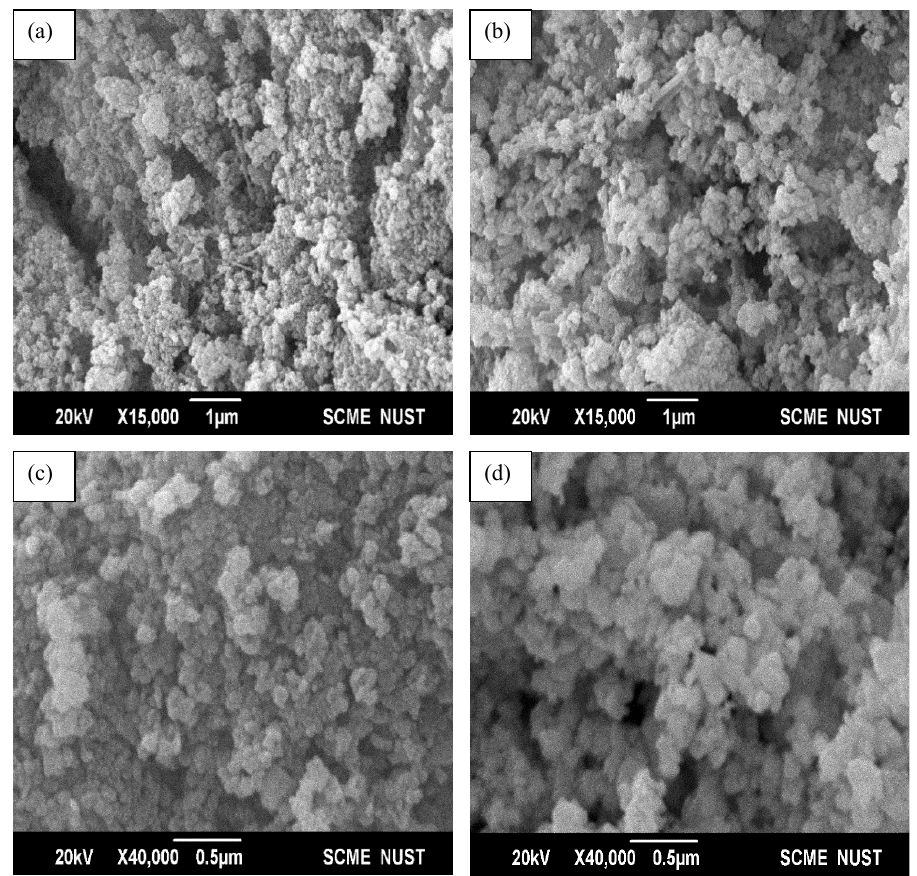
Figure 2. SEM images of ( a ) Mn 3 O 4 NPs, ( b ) NiO NPs, ( c ) 1:1 Mn 3 O 4 /NiO NC, and ( d ) 3:1 Mn 3 O 4 /NiO NC.